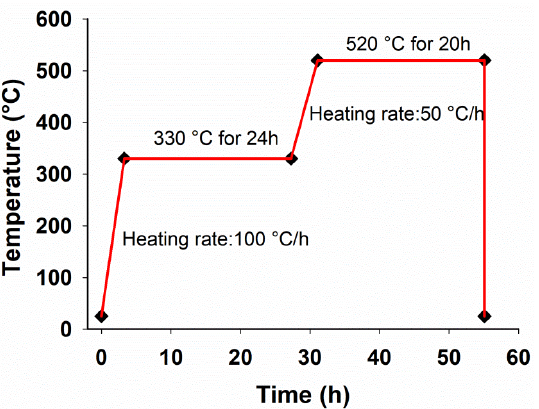
Figure 1. The thermal cycle of solution treatment process considered for Mg-5Sn-xTi (x = 0, 0.15, 0.75, 1.5 wt.%) alloys. 1.5 wt.%)